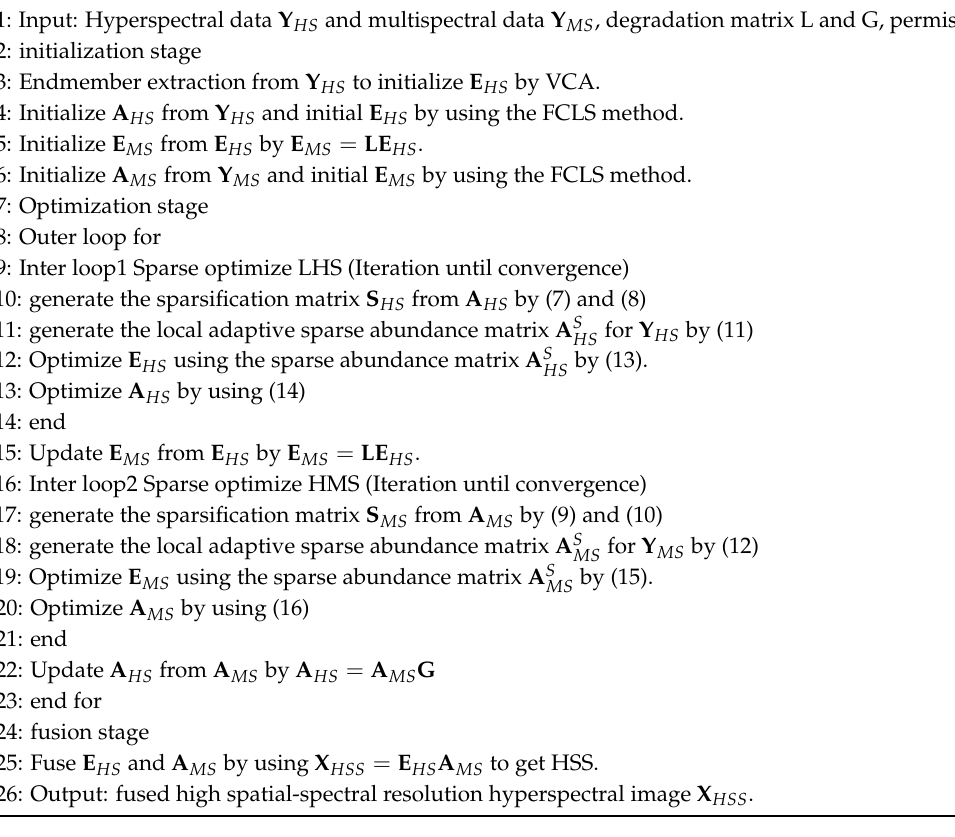
Algorithm 1 Local Adaptive Sparse Unmixing Based